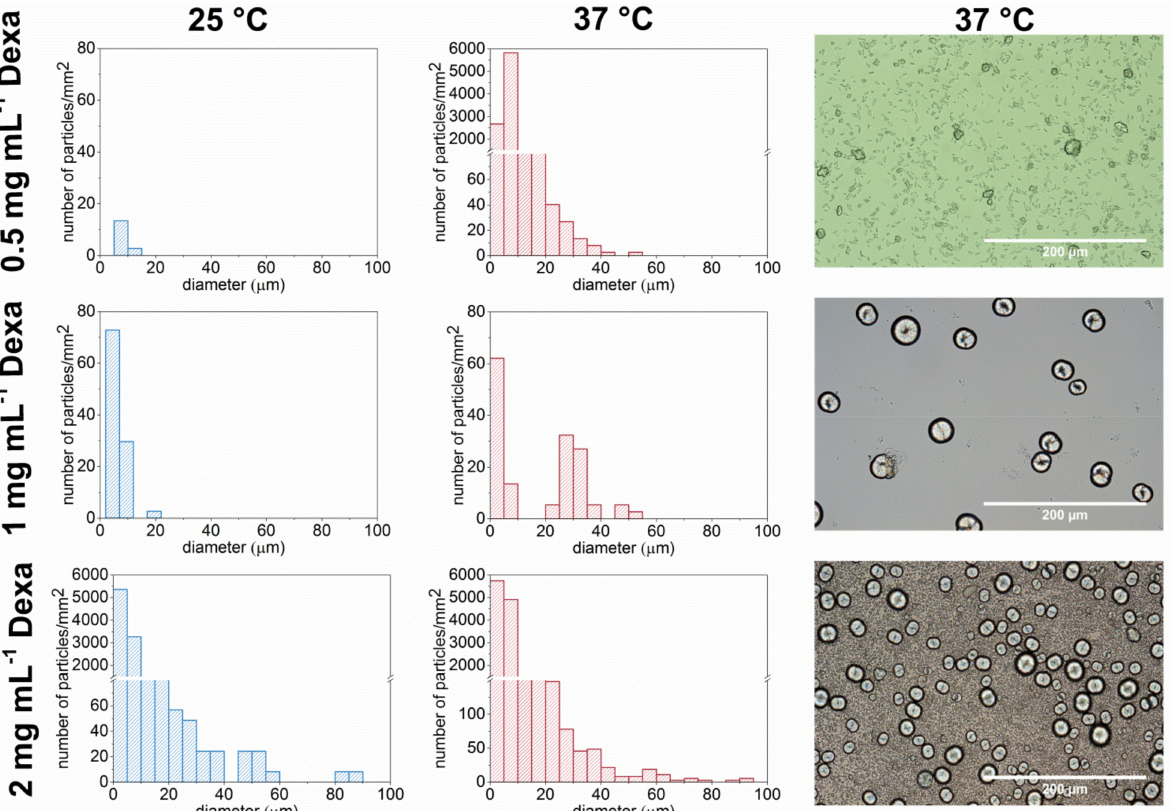
Figure 4. The comparison of morphology and number of microparticles formed from P1 copolymer (10 mg · mL − 1 ) and Dexa of various concentrations at 25 ◦ C and 37 ◦ C in PBS. The sample droplet was observed under an optical microscope with a heating plate. The images were evaluated using ImageJ software. The number of the particles per mm 2 is calculated from three different locations on the